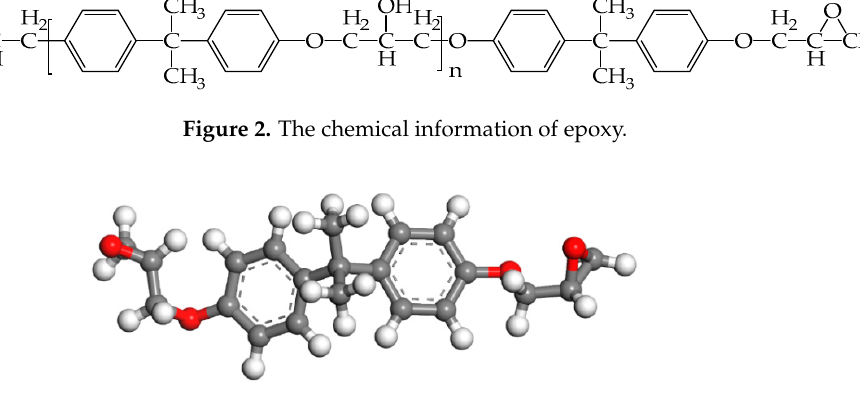
Figure 3. The model of E-51( n = 0; colour legend: hydrogen H (white); oxygen O (red); carbon C (grey)).